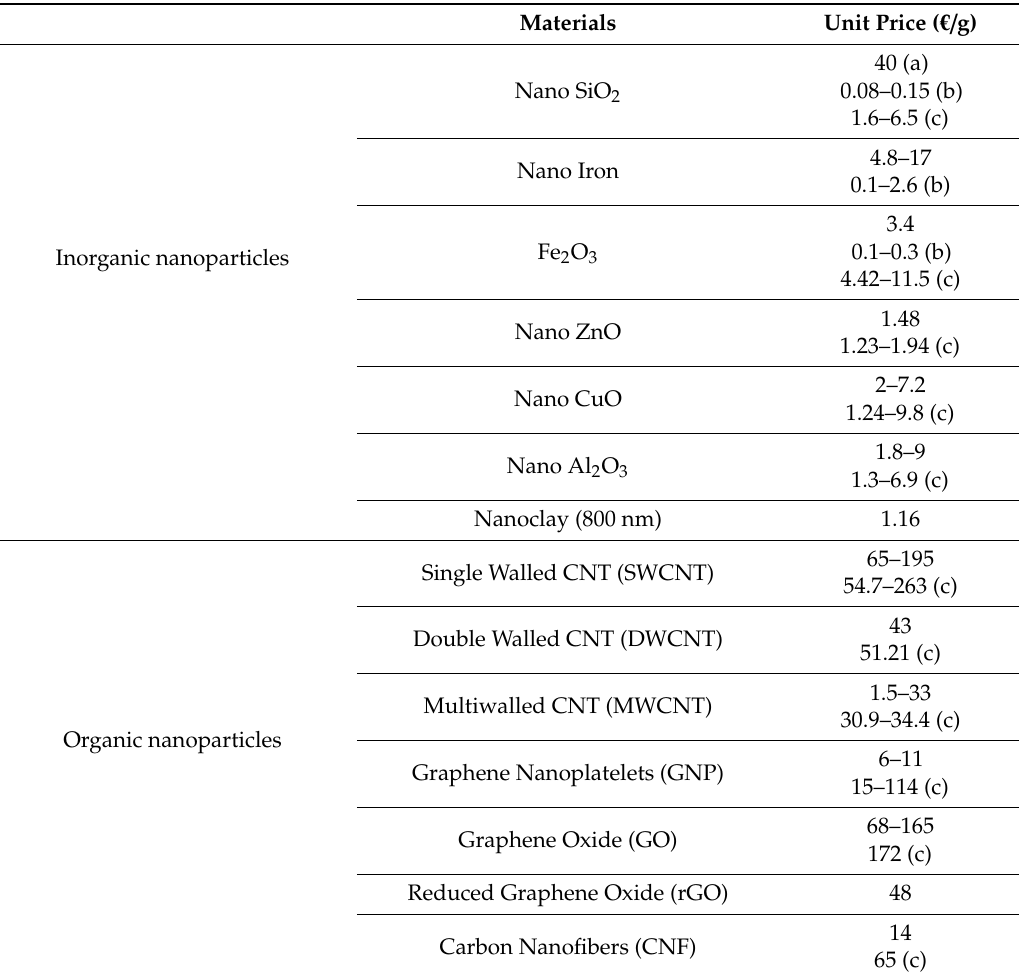
Table 2. Costs of inorganic and organic nanoparticles used as additive in bitumens and asphalt concrets; (a) Laser Synthesized; (b) from [42]; (c) from